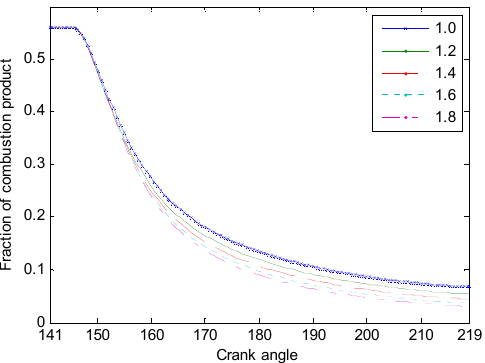
Figure 1. Simulation value of χ g with di ff erent ξ during the scavenging process. ( χ g : composition of gas in the cylinder ξ : coe ffi cient to adjust the scavenging quality).